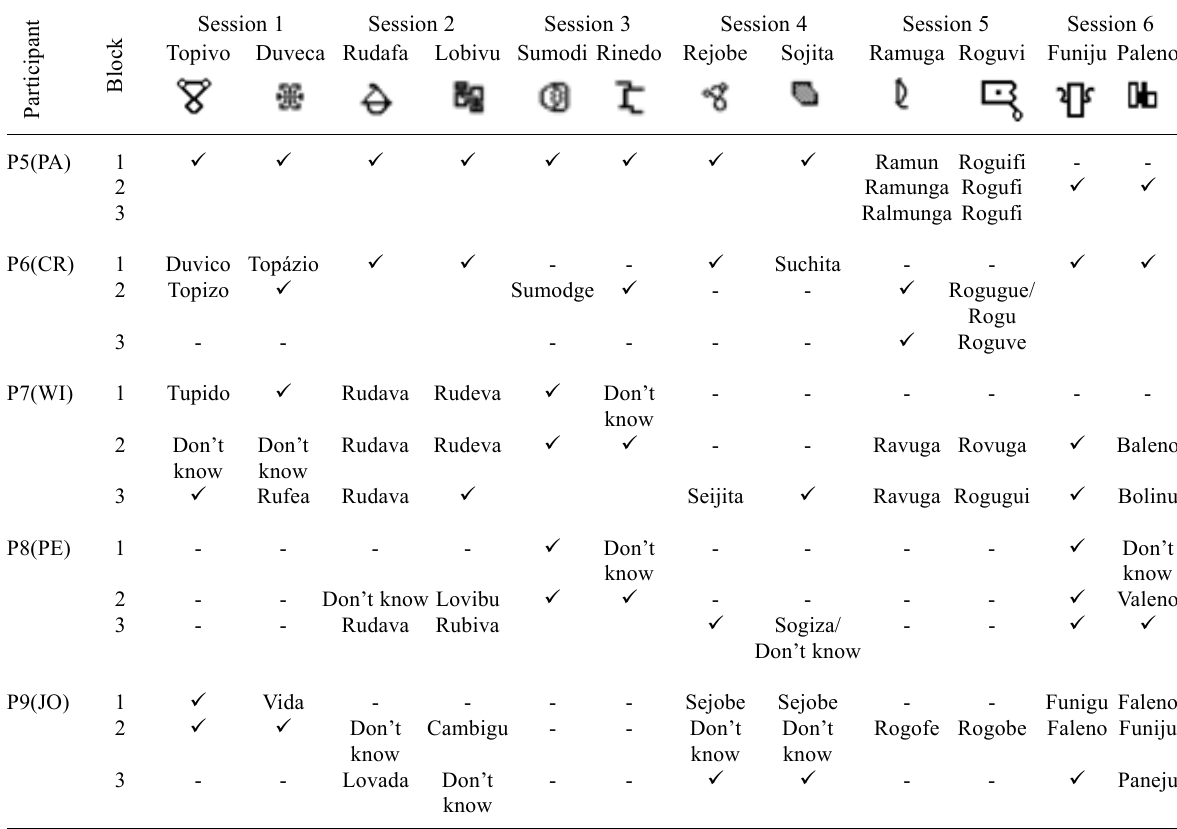
Naming of thePictures for the Participants of Study 2. Tics Indicate Correct Naming Responses; Dashes Indicate that the Naming Block was not Performed; Words Indicate Incorrect Naming